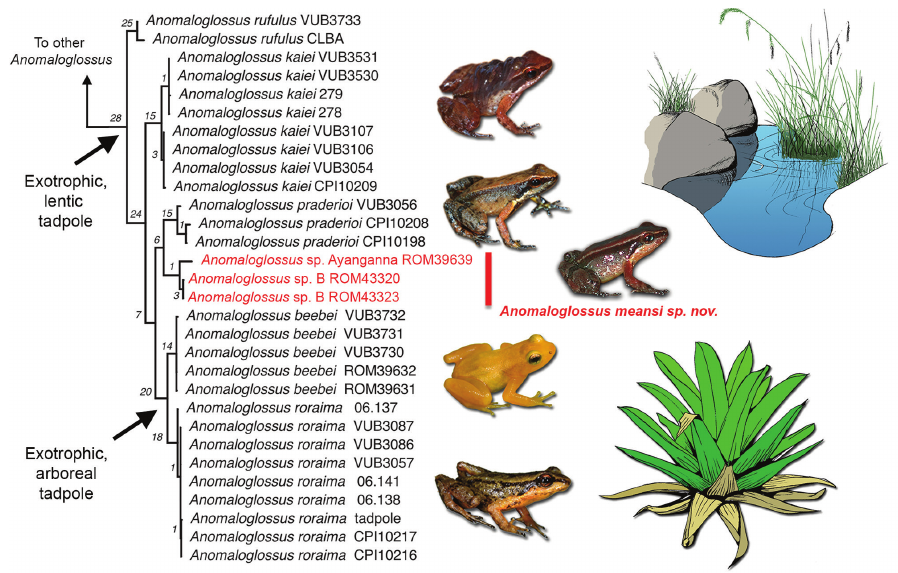
Figure 1. Optimal relationships of the Anomaloglossus beebei group (modified from Grant et al. 2017). Numbers at nodes are Goodman-Bremer values. The new species is highlighted in red. Anomaloglossus photos are by PJRK, except A. meansi , which is by D. Bruce Means. Drawings by Kim